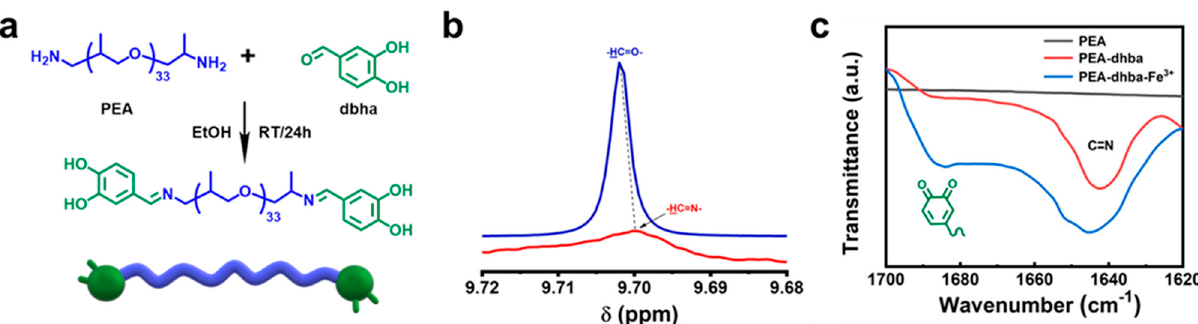
Figure 1. ( a ) Synthetic routes of PEA-dhba; ( b ) 1 HNMR spectra of dhba and PEA-dhba-Fe 3+ ; ( c )